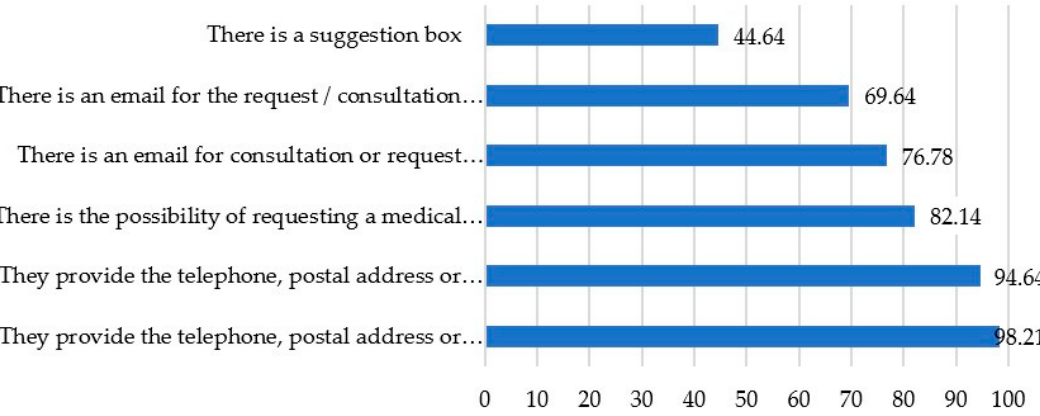
Figure 4. Representation of “Information offered” variable with indicators related in number of hospitals accomplishing them. The number of medical centers that identify their staff by title and name is 69.64%; while only 48.21% of the sites analyzed provide information on the organization chart of management positions and their functions in the hospital. The study identifies that there is no habit of providing information